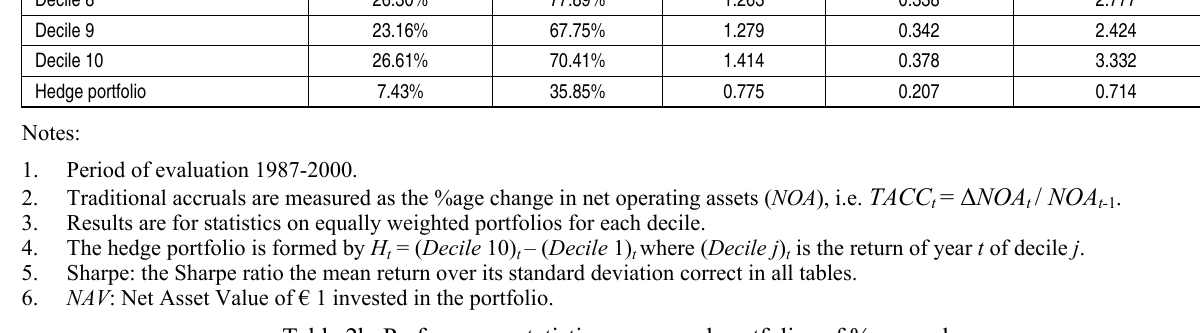
Table 2b. Performance statistics on accrual portfolios of %